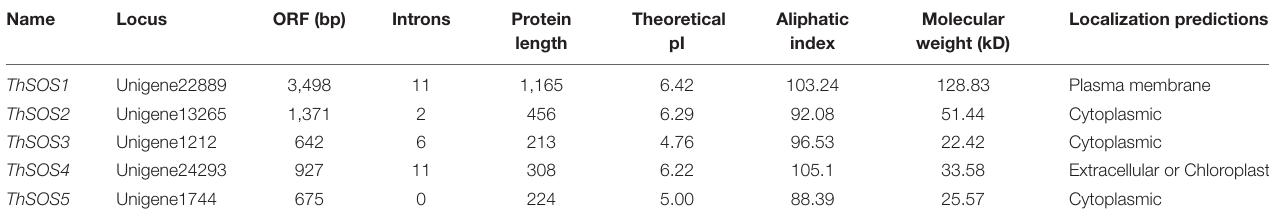
TABLE 2 | Features of ThSOS genes in T. hispida